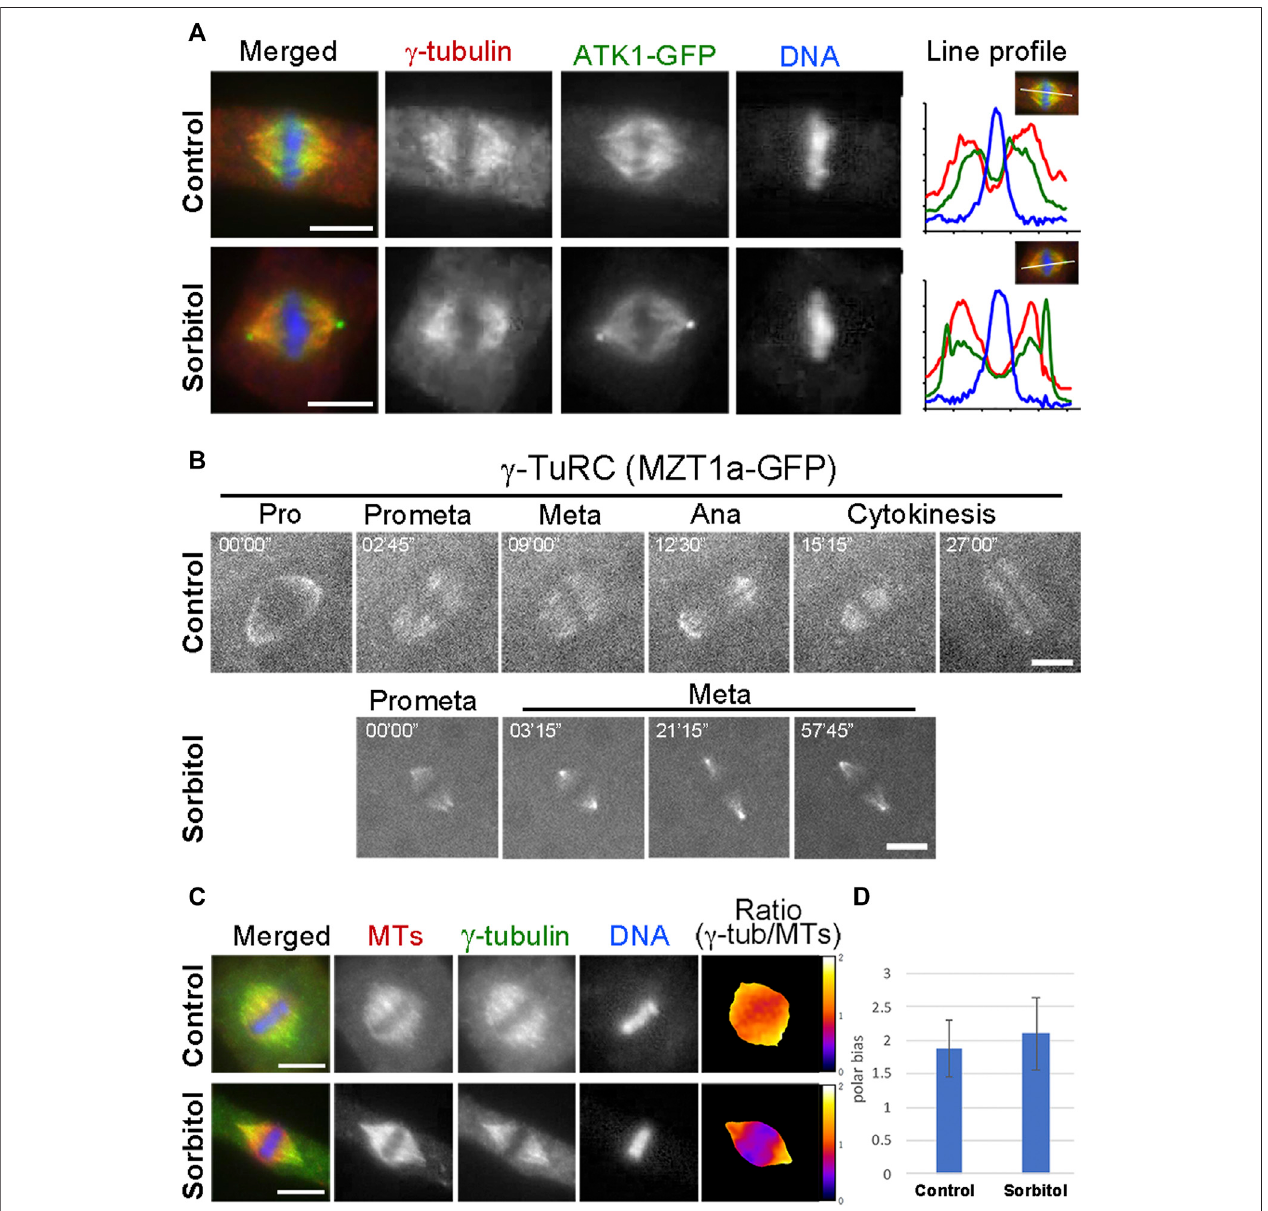
FIGURE 6 | γ -TuRC exhibits a different poleward localization pattern than ATK1-GFP. (A) γ -Tubulin shows a spindle pole-biased localization pattern without sorbitol. But the ATK1-GFP-highlighted pseudo-centrosomes lack the γ -tubulin signal, as indicated by the line pro fi les re fl ecting the fl uorescence intensities of the three signalsshown. (B) Live-cellimagingof γ -TuRCwasreportedbytheMZT1a-GFPfusionprotein.AlthoughthereismoreMZT1a-GFPsignalatthetwopolesatlatertimes, itnever appears in discrete foci. (C) Comparison of γ -tubulindistribution alongthe spindle axis.The γ -tubulin fl uorescence signal isanalyzed using that ofMTs asa reference.Theratioof γ -tubulinandMTsignalsisrepresentedinpseudocolorswithmetersattachedontheright. (D) Polar-biasedlocalizationof γ -tubulinisquanti fi edin the control and sorbitol-treated cells. Scale bars, 5 µm.